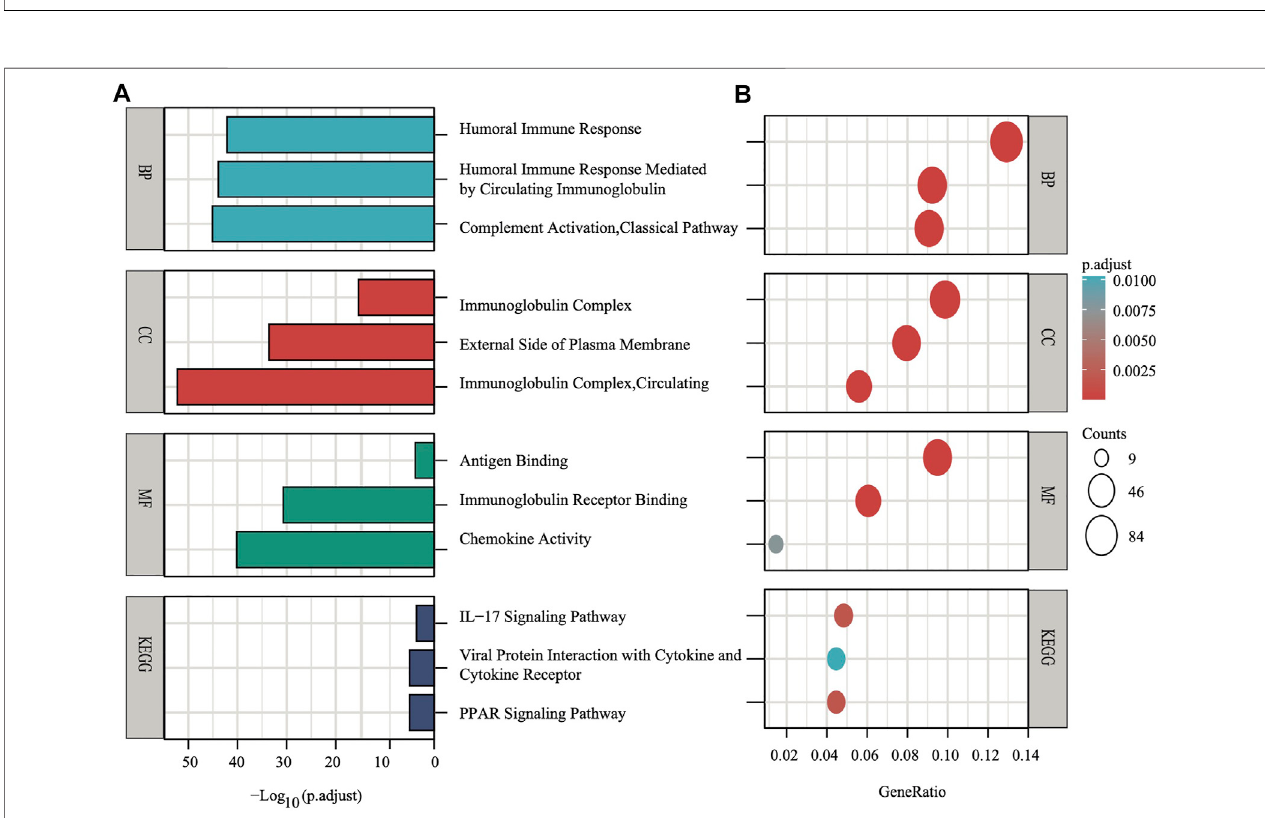
FIGURE5| The X -axisdepicts adjust p values, whereas the Y -axisdepicts theenriched mechanism orpathway (A) .The X -axis depicts thegeneratiointhe overall number of differential expression genes between two subgroups, whereas the Y -axis depicts the enriched mechanism or pathway (B) .